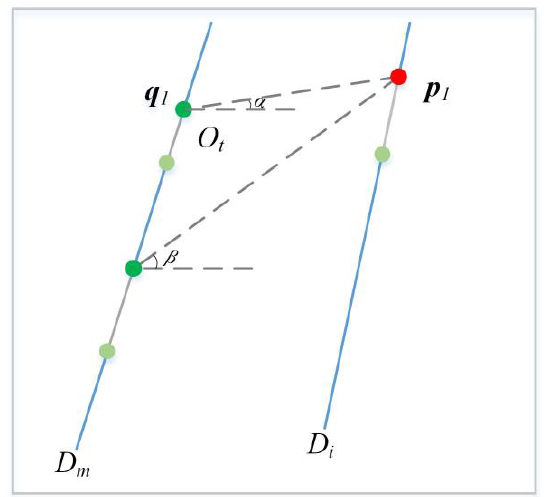
Figure 4. Diagram for the Neighborhood Point Set Solution.